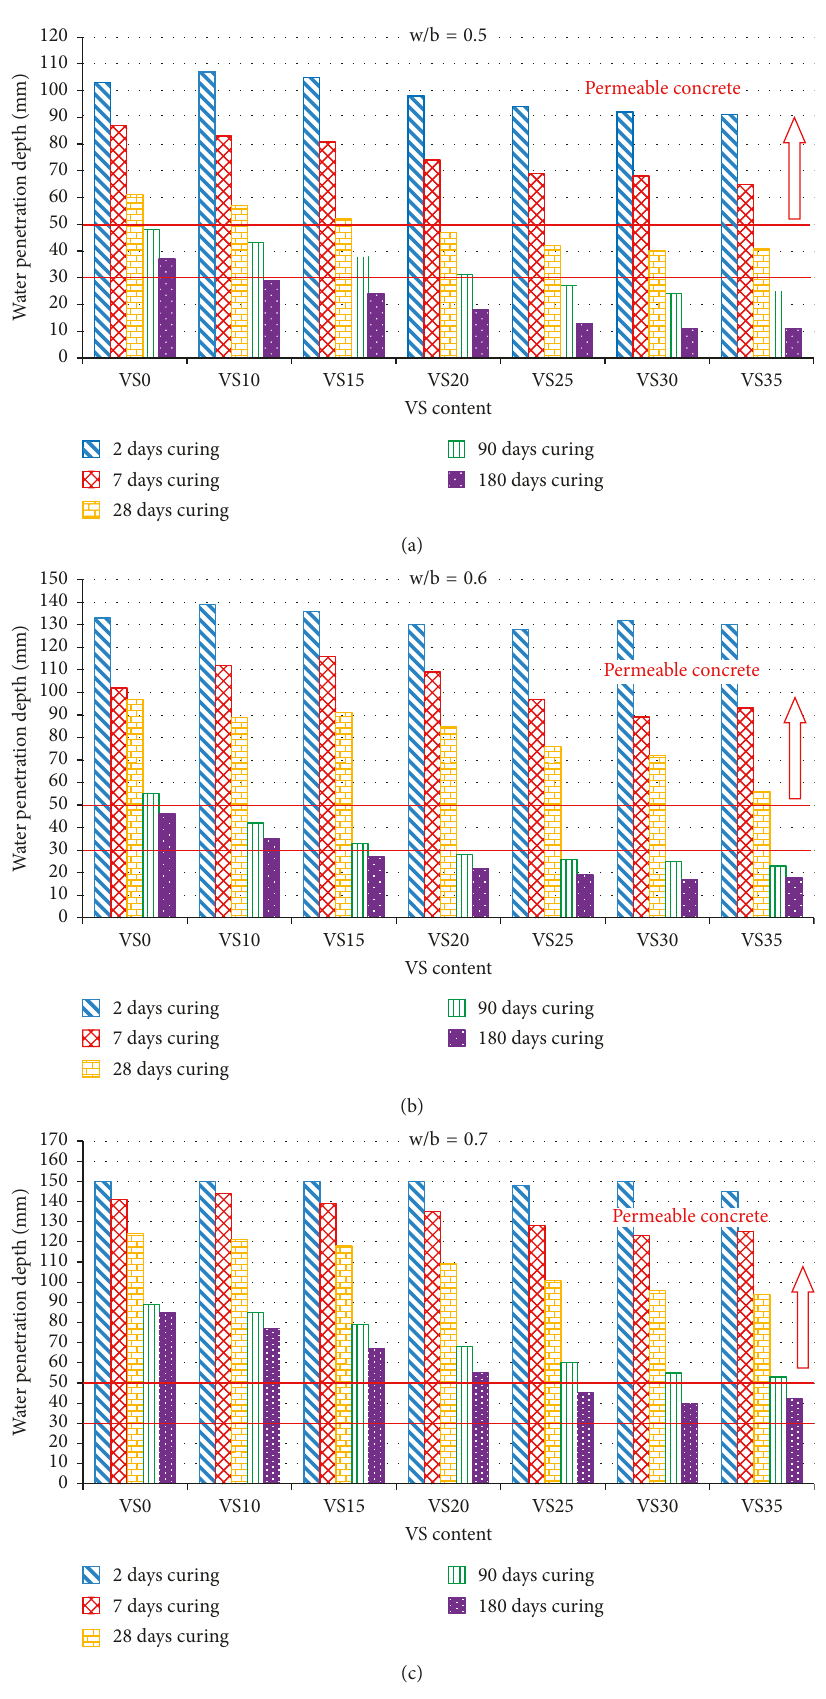
Figure 10: Water penetration depths of VS-based binder concretes of various w/b ratios cured for different times: (a) w/b � 0.5; (b) w/b � 0.6; (c) w/b �